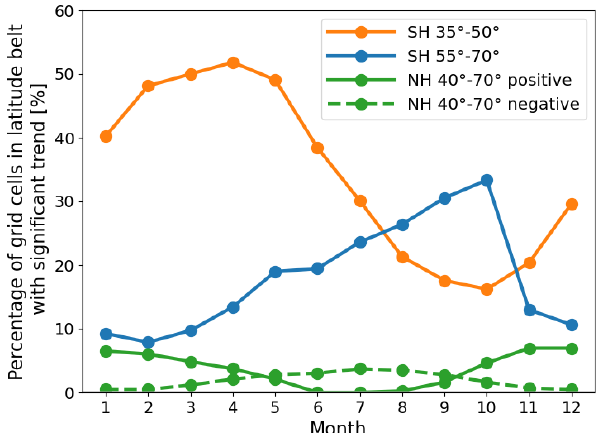
Figure 8. Percentage of grid cells indicating a significant trend as a function of month for the latitude bands 40–70 ◦ N (green), 35– 50 ◦ S (orange), and 55–70 ◦ S (blue). The number is provided in per- cent of the total number of grid cells in the respective band. For the Northern Hemisphere (green) a division between significant posi- tive (solid curve) and significant negative (dashed curve) trends is